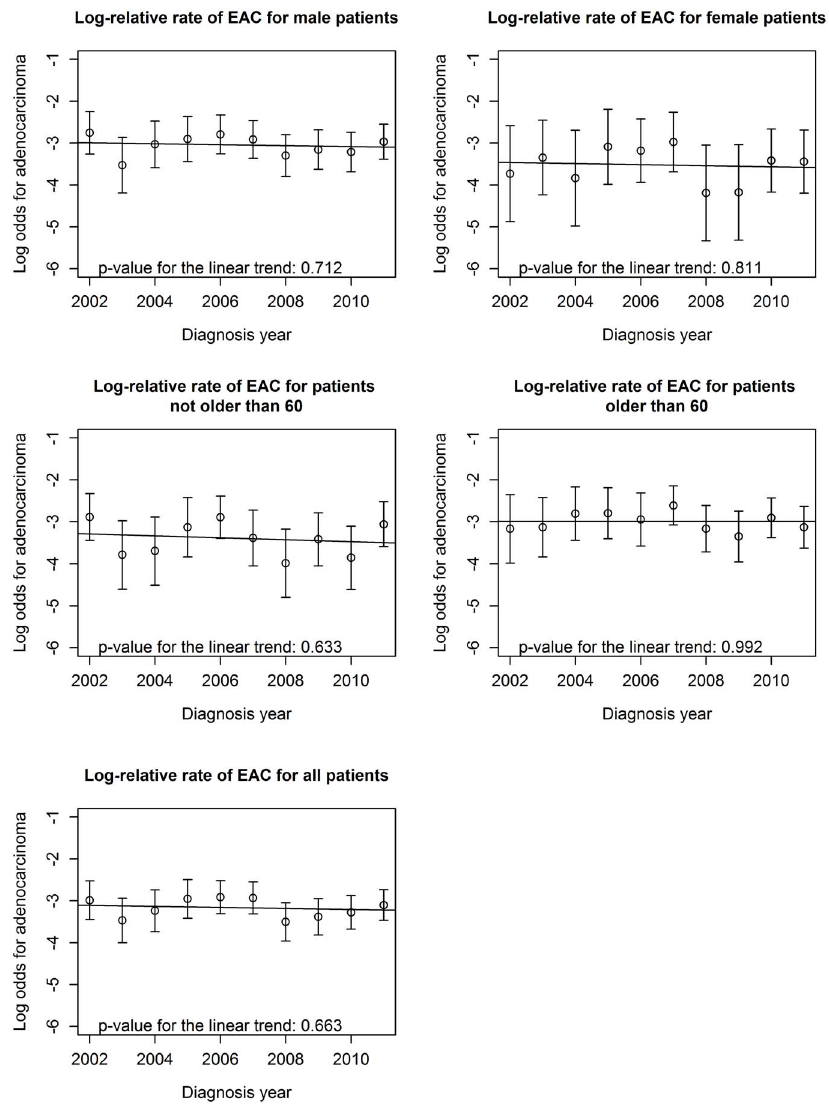
Figure 1. Log odds for esophageal adenocarcinoma among esophageal cancer over the study period (2002–2011).